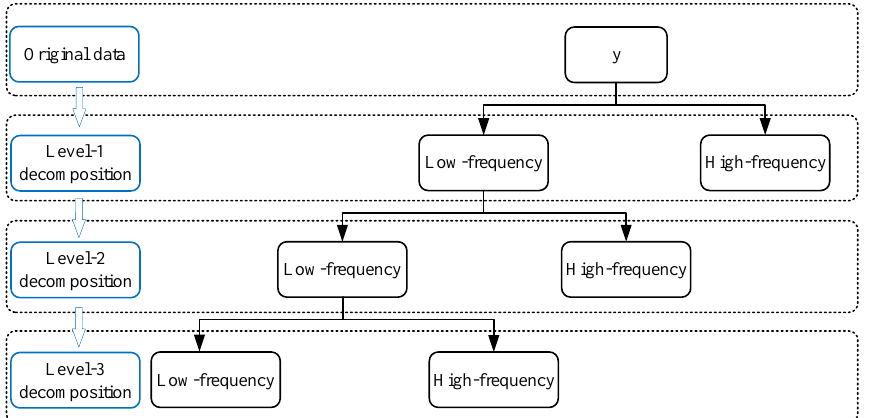
Figure 1. Schematic diagram of three-layer wavelet decomposition.